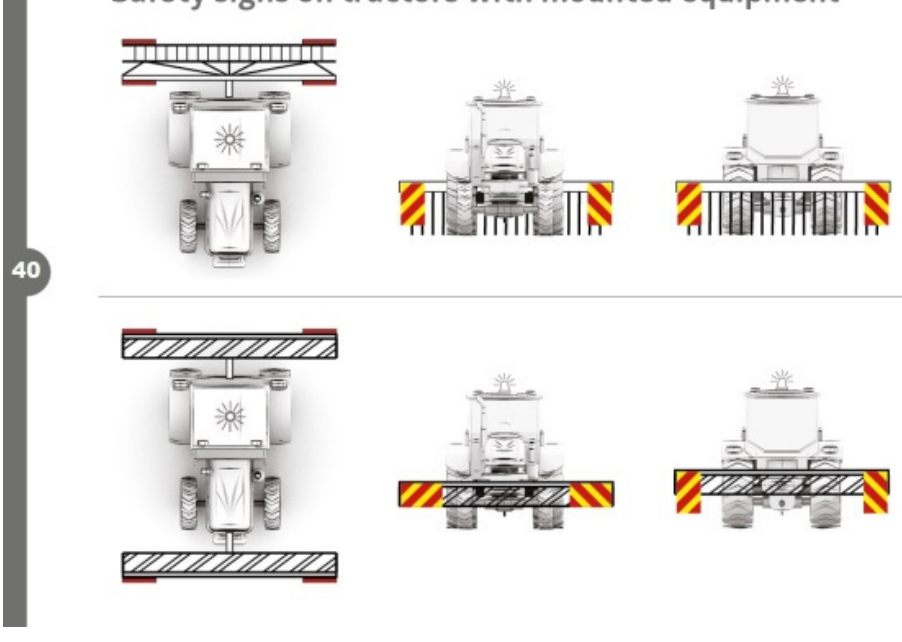
Figure 13. Example of practical illustrations.